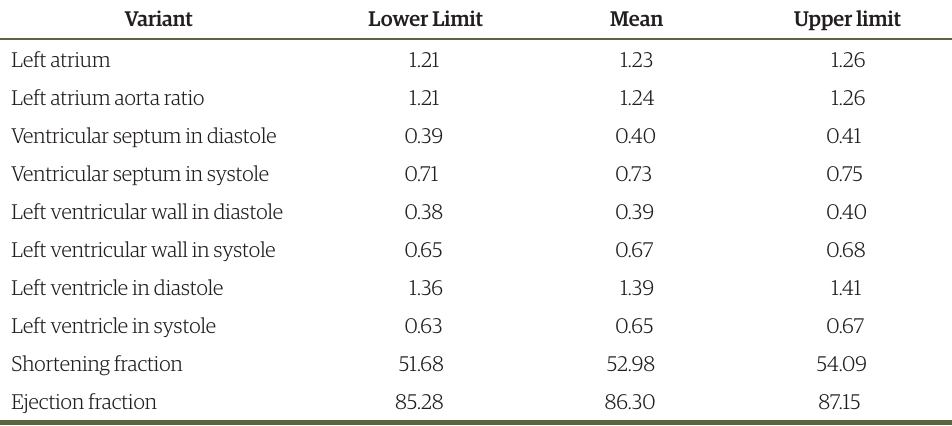
Table 2. Proposed reference values (mm) of the M-mode echocardiography measurements for Brazilian domestic short hair